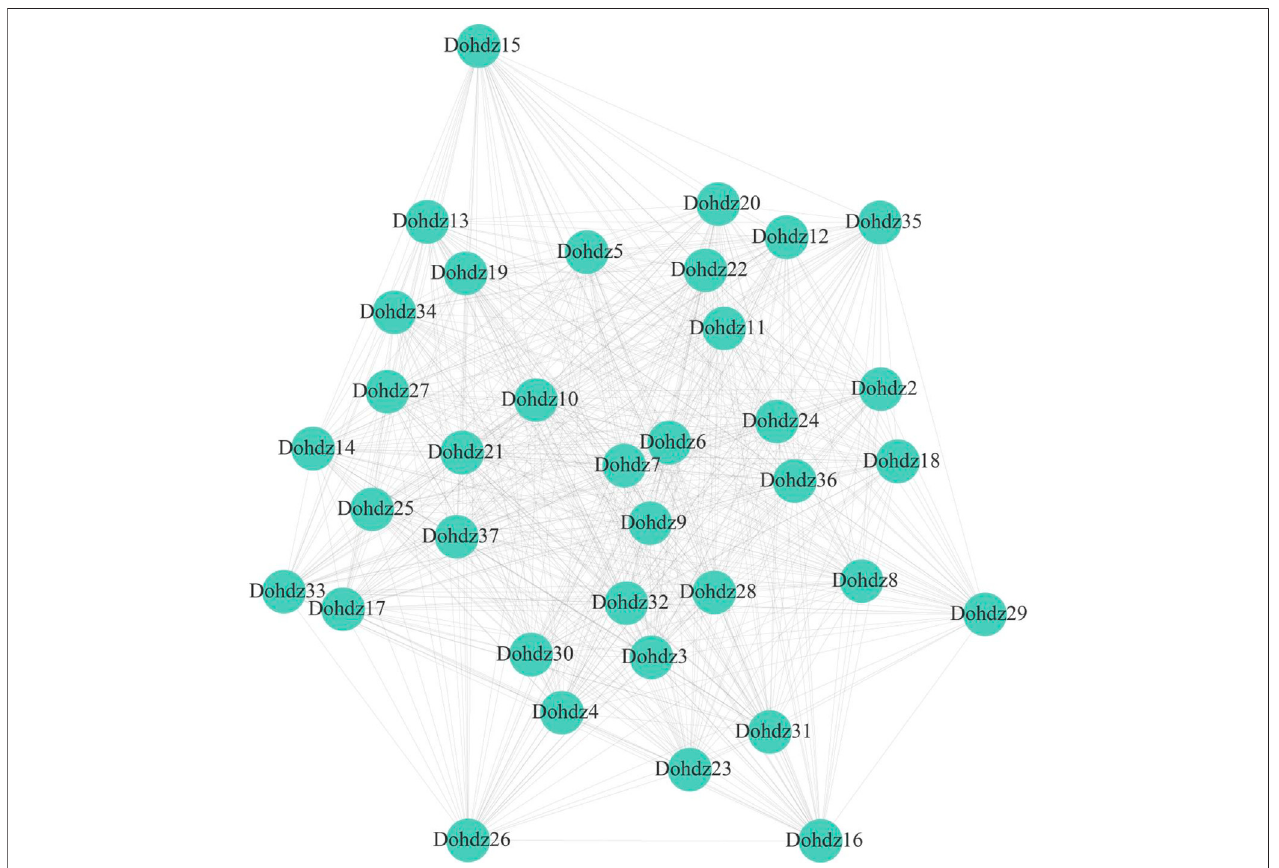
FIGURE 5 | Coexpression network of Dohdz genes involved in regulating other genes in D. of fi cinale